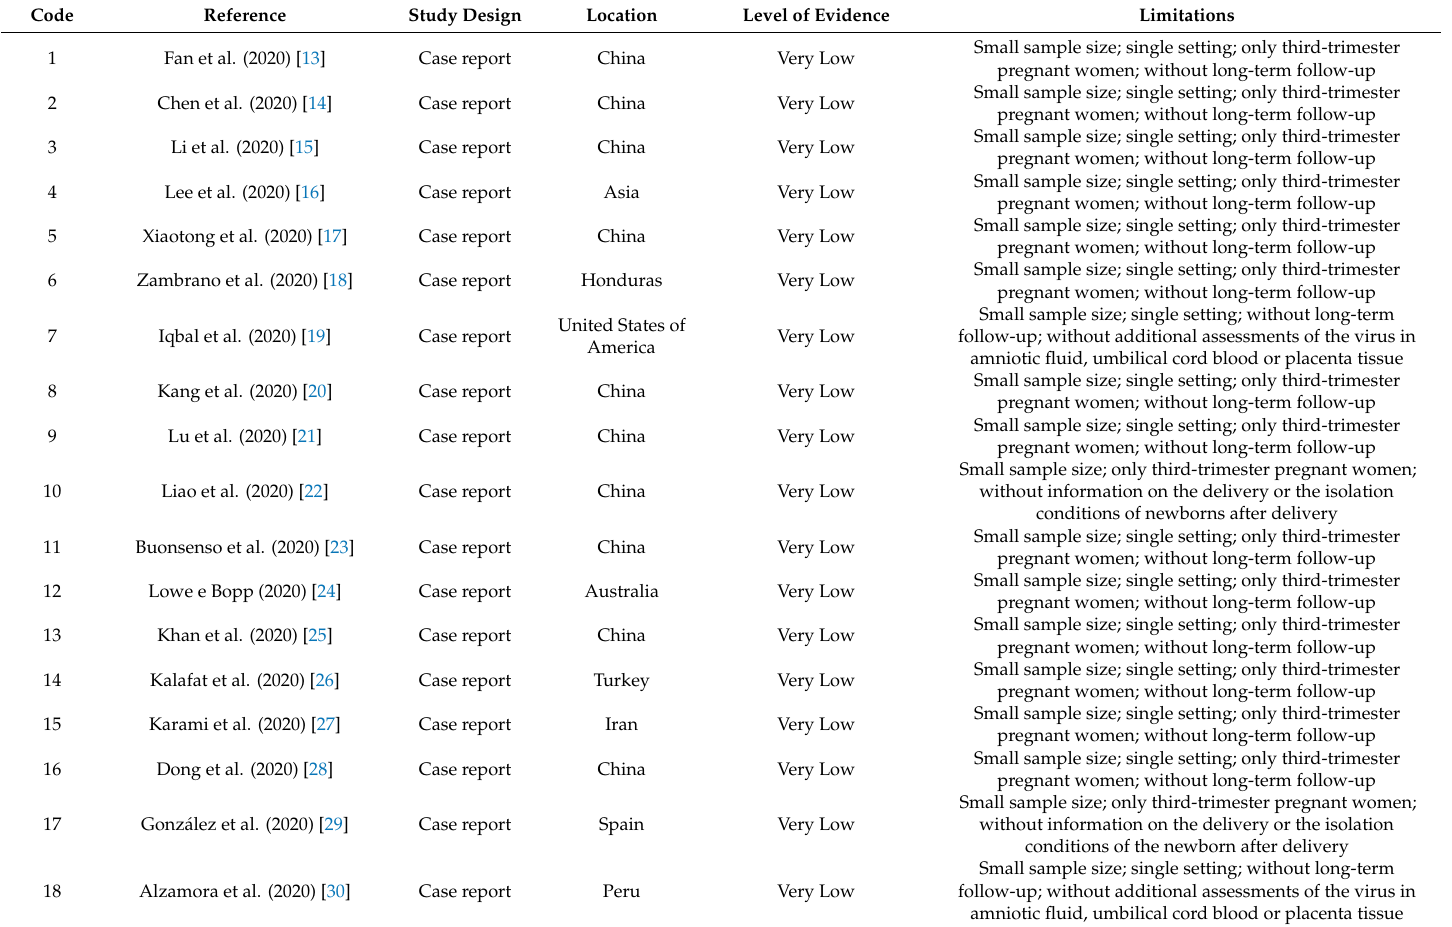
Table 1. Characteristics of included studies: reference, study design, location, level of evidence, and